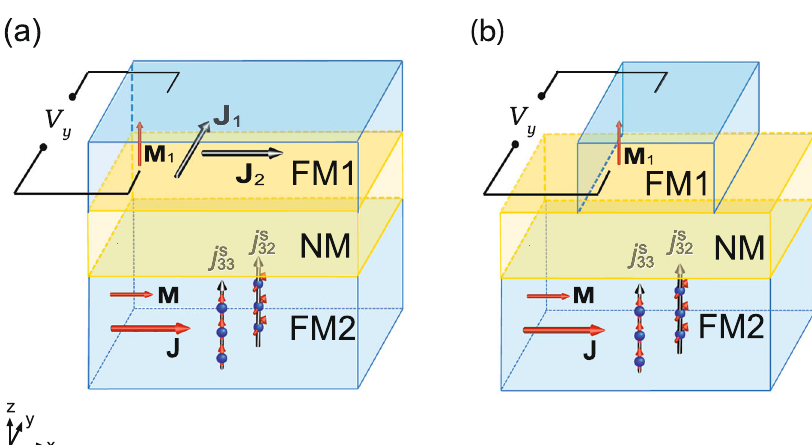
Fig. 3 (Color online) Proposed setup for experimental veri fi cation. A multilayer fi lm lying in the xy -plane consists of a ferromagnetic metal layer 1 (FM1) on the top, a non-magnetic layer (NM) in the middle, and a ferromagnetic metal layer 2 (FM2) on the bottom. The magnetization of FM2 is M (the thinner red arrowed line). Applied charge current J (the thicker red arrowed line) is collinear with M and is along the ^ x direction. FM1 is for spin current detection whose magnetization M 1 is along the ^ z direction. Spin currents j s and j s (the black arrowed lines decorated with smaller arrows) are respectively 33 32 generated by the anomalous ( j s ) and conventional spin Hall effect. The two spin currents passing thought the spacing layer and enter into the top 33 ferromagnetic metal layer FM1. J 1 and J 2 are two charge currents respectively from the anomalous inverse spin Hall effect and the conventional inverse spin Hall effect. A voltage drop V y across the ^ y direction in FM1 is generated by J 1 . a A setup for NM being a thin insulating spacing. b For NM being a metal, FM1 is replaced by a Hall bar along the ^ y